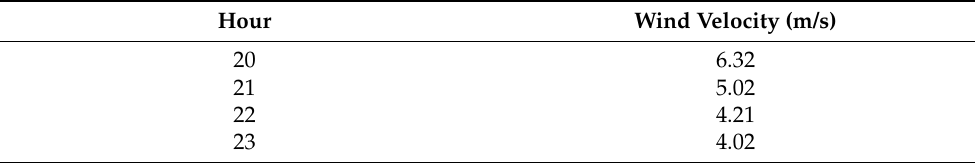
Table 6. emphCont.